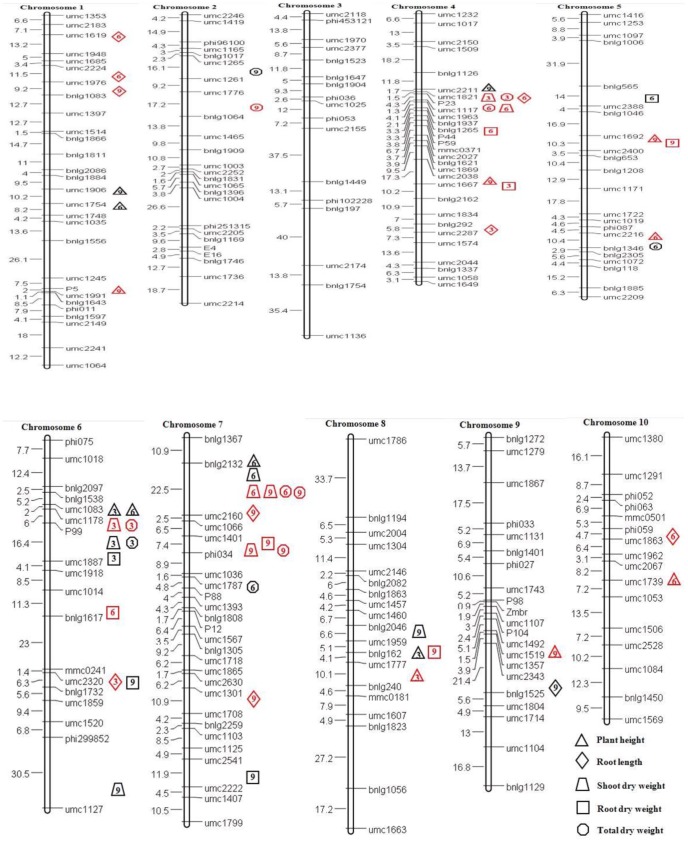
Positions of conditional QTL for five seedling morphological traits across three independent pot experiments (measured at the 3, 6 and 9 d of waterlogging) on linkage groups by ICIM.The number on the left side of each chromosome is the genetic distance between markers in cM. QTL are shown at the right side of each chromosome in different shapes for each trait and different colors for different treatments (black: control; red: waterlogging treatment).